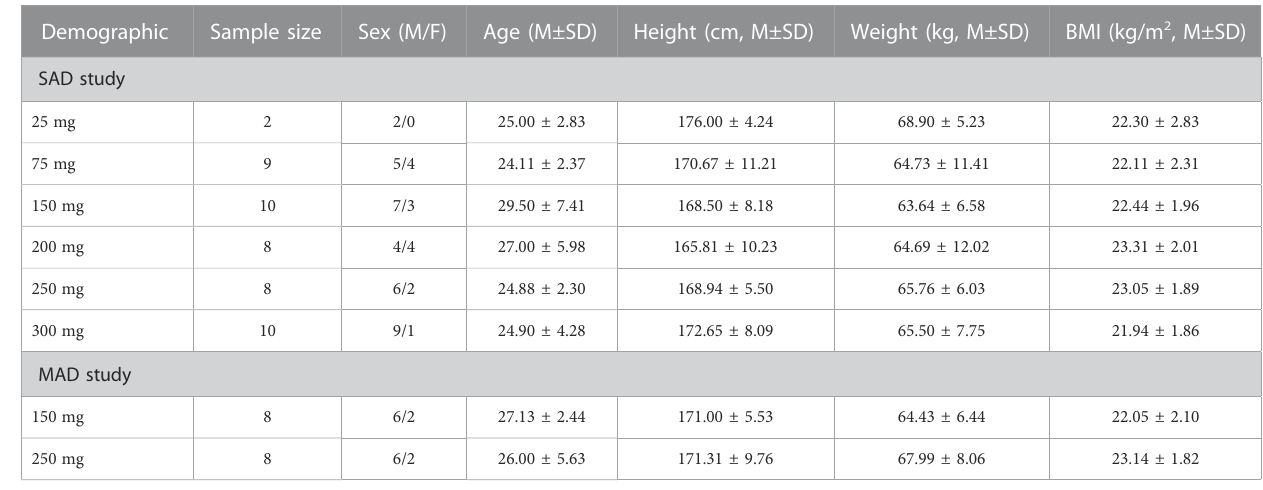
TABLE 1 Volunteer